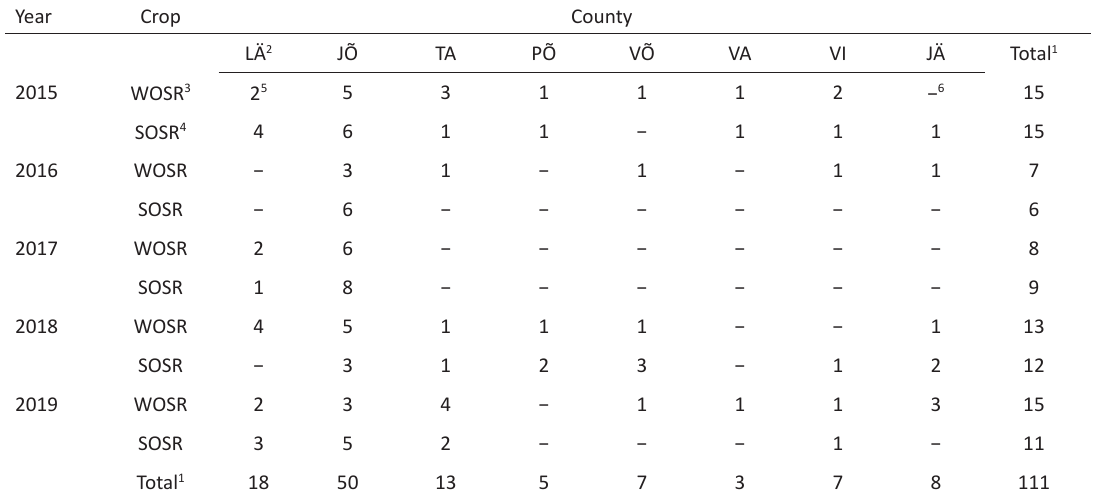
Table 1. Collection of pollen beetle samples from eight of the main oilseed rape growing counties, between 2015 and 2019